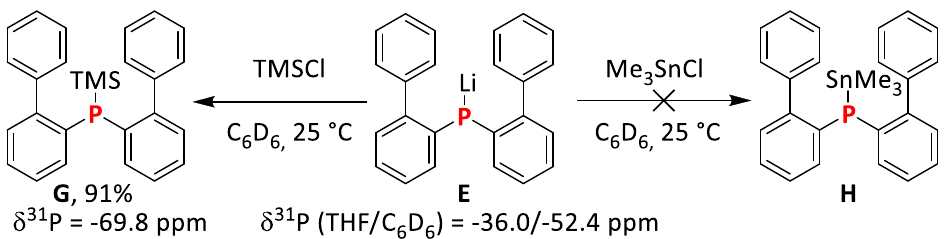
Scheme 8. Reaction of phosphide E with two trimethyl tetrel chlorides.